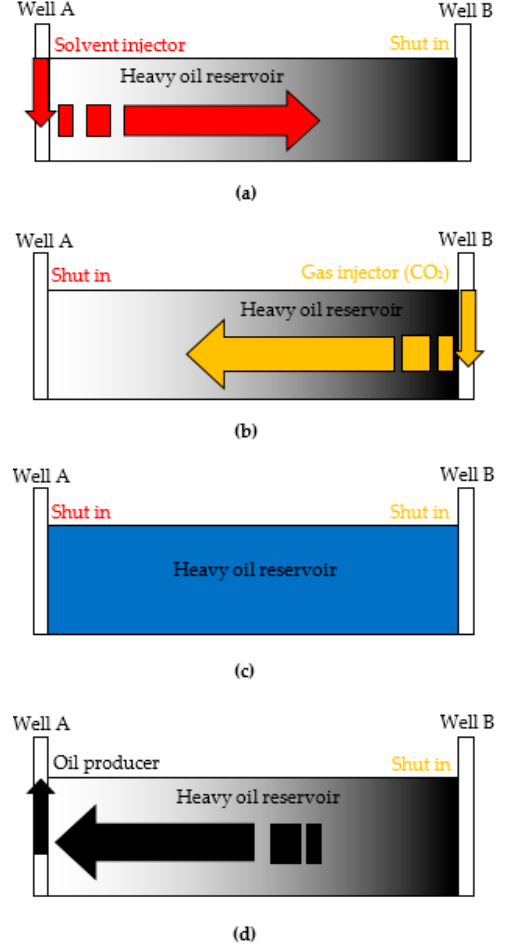
Figure 4. Flow charts of four periods in each cycle of the solvent-assisted gas pressure cycling (SA-GPC) process in a two-well configuration: ( a ) solvent injection from Well A; ( b ) gas injection from Well B; ( c ) solvent and gas soaking; and ( d ) fluids production from Well A.